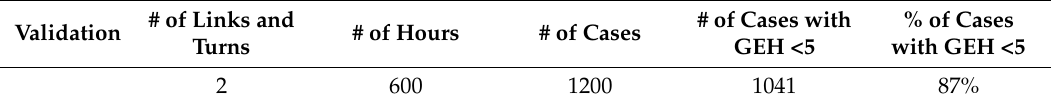
Table 5. Summary of the result of traffic volume validation.